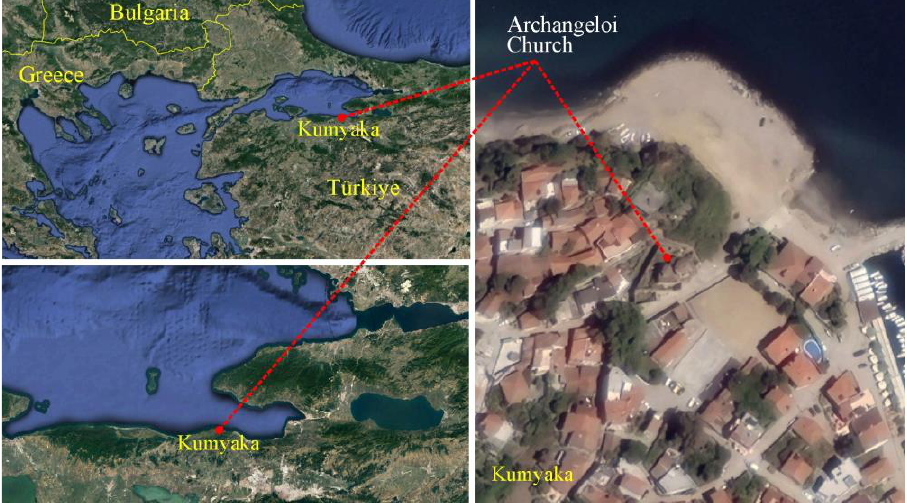
Figure 1. Location of the Archangeloi (Başmelekler) Church.